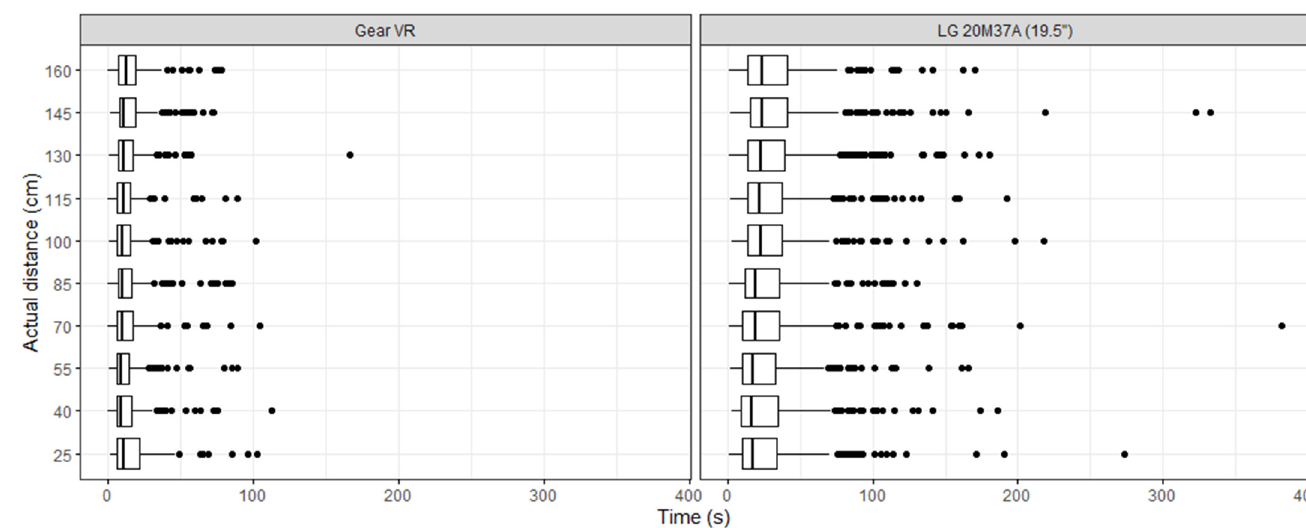
Figure 3. Estimation times grouped by display devices.